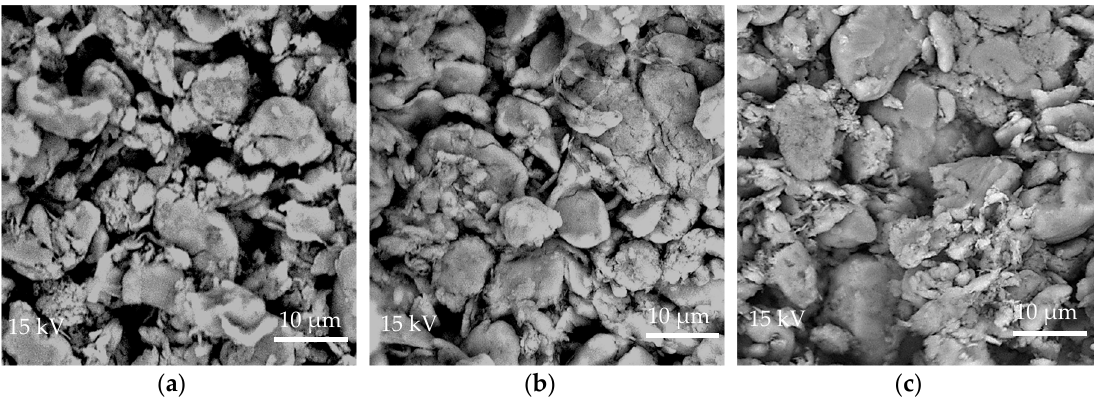
Figure 1. SEM micrographs of micro-PTFE etched for ( a ) 0 min; ( b ) 10 min; and ( c ) 17.1 min.